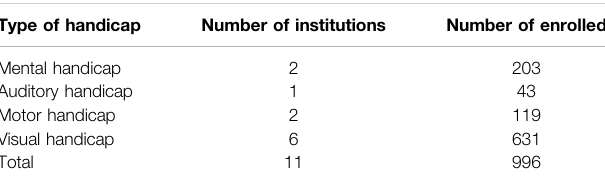
TABLE 1 | Distribution of public special education and rehabilitation establishmentsbytypeofdisability2009(InitialreportonTunisia ’ scompliance with article 35 of the International Convention on the Rights of Persons with Disabilities 2010, 34).